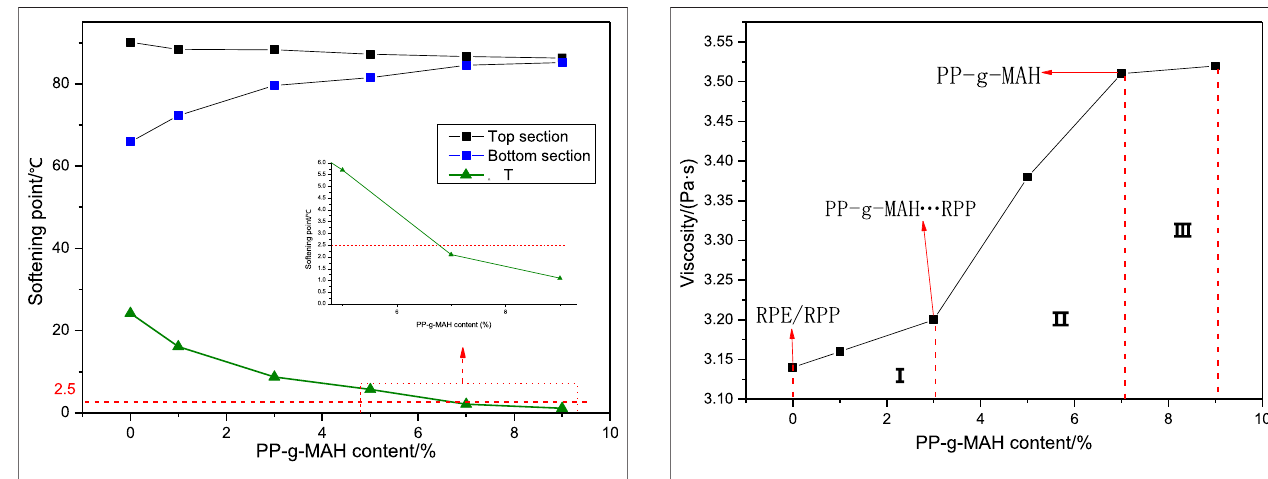
FIGURE7| EffectofPP-g-MAHcontentonsofteningpointsofmodi fi ed. asphalt at top and bottom section.